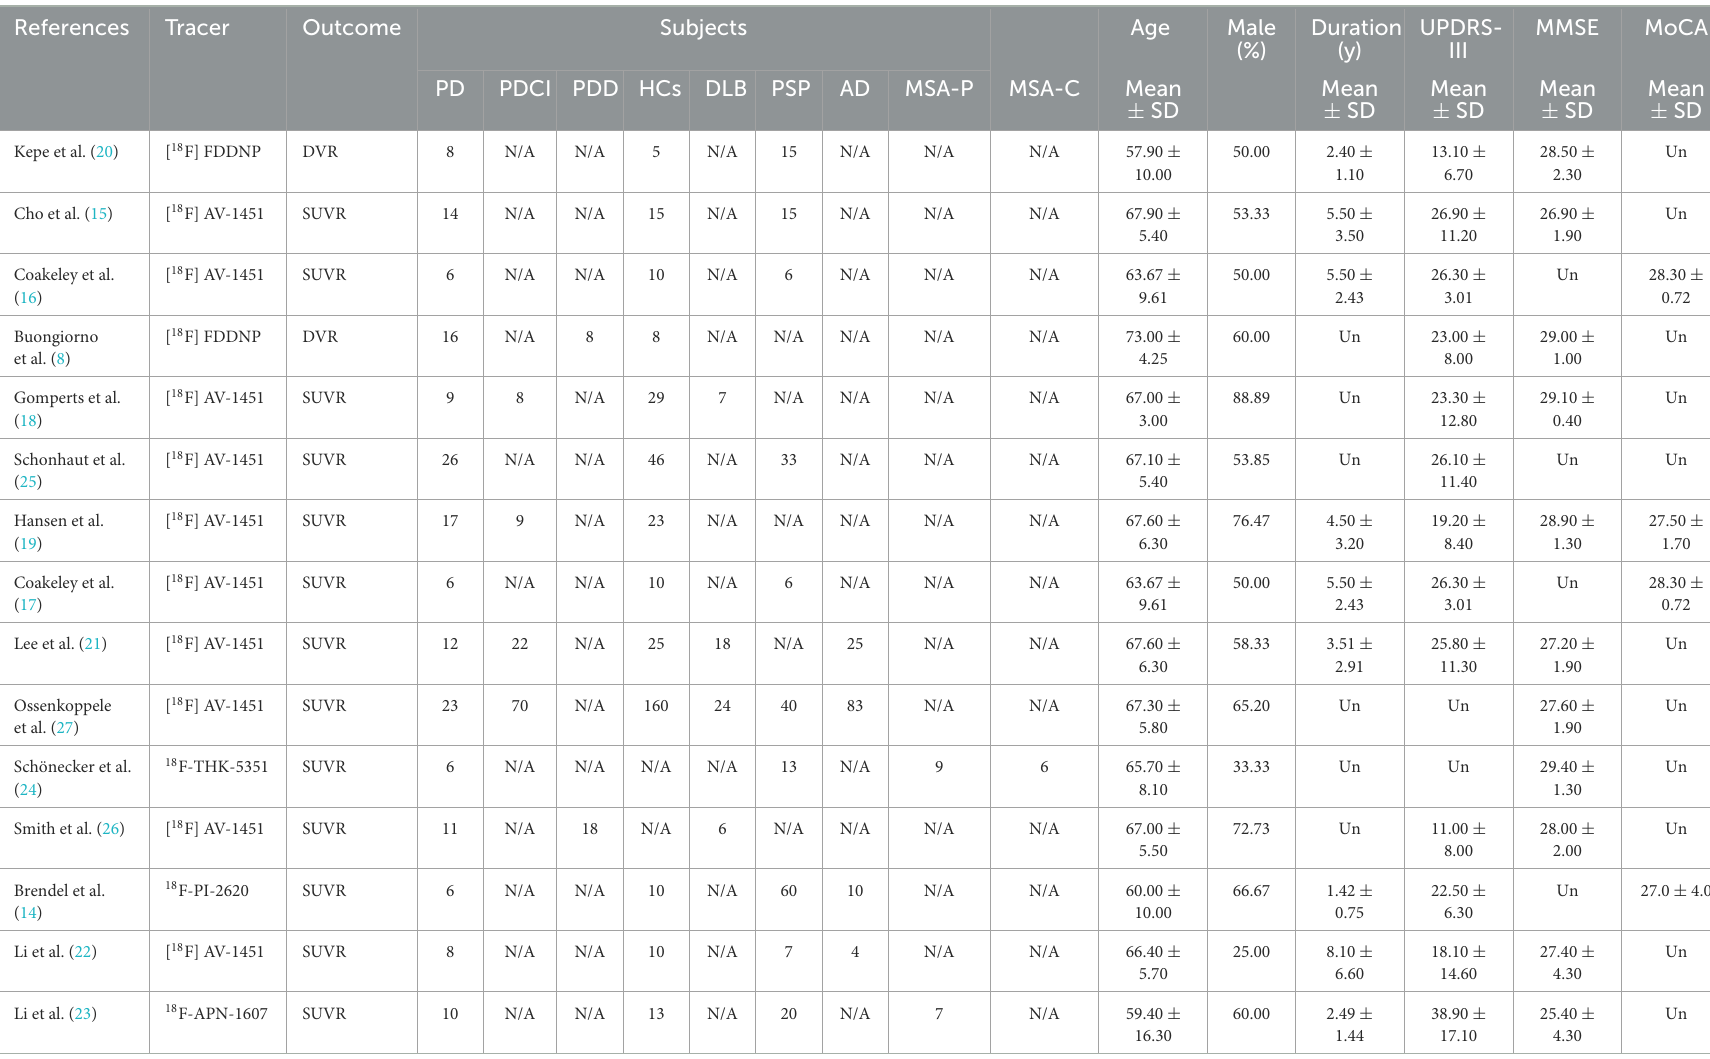
TABLE 1 Characteristics of included